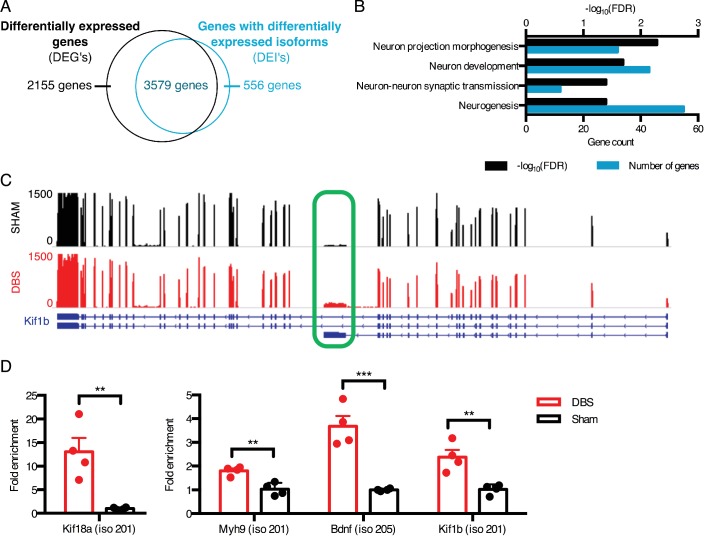
DBS revealed hundreds of activity-dependent splicing changes in genes that would be overlooked by differential gene analysis.(A) Overlap between genes that are differentially expressed with DBS (fold-change >20%; FDR < 0.05) and genes with differential isoform expression following DBS in WT mice (Fold-change >30%; FDR < 0.05). (B) Gene ontology (GO) analysis of genes showing differential isoform expression but not an overall change in gene expression following DBS. (C) Representative RNA-sequencing tracks from WT sham (black; max: 1500 reads) and WT DBS (red; max: 1500 reads) mice showing the expression of the Kif1b gene, along with annotated Kif1b isoforms (shown in blue). The shortest isoform is differentially expressed post-DBS, and the green box indicates the unique region of the shortest isoform where RT-qPCR primers were located to check transcript levels in a new cohort. (D) RT-qPCR validation of DBS upregulated isoforms in a new cohort of WT mice (n = 4 sham, 4 DBS mice; significance determined using an unpaired, two-tailed t-test; error bars: SEM; **p<0.01; ***p<0.001). Source data for RNA isoforms quantification can be found in Figure 2—source data 1. The complete list of GO terms and scores for genes with differentially expressed isoforms that are not differentially expressed at the whole gene level can be found in Figure 2—source data 2.10.7554/eLife.34031.010Figure 2—source data 1.Isoform expression data from wild-type sham and DBS-treated mice.10.7554/eLife.34031.011Figure 2—source data 2.Gene ontology data for genes in wild-type samples with differentially expressed isoforms (DEIs) that are not differentially expressed at the gene level.